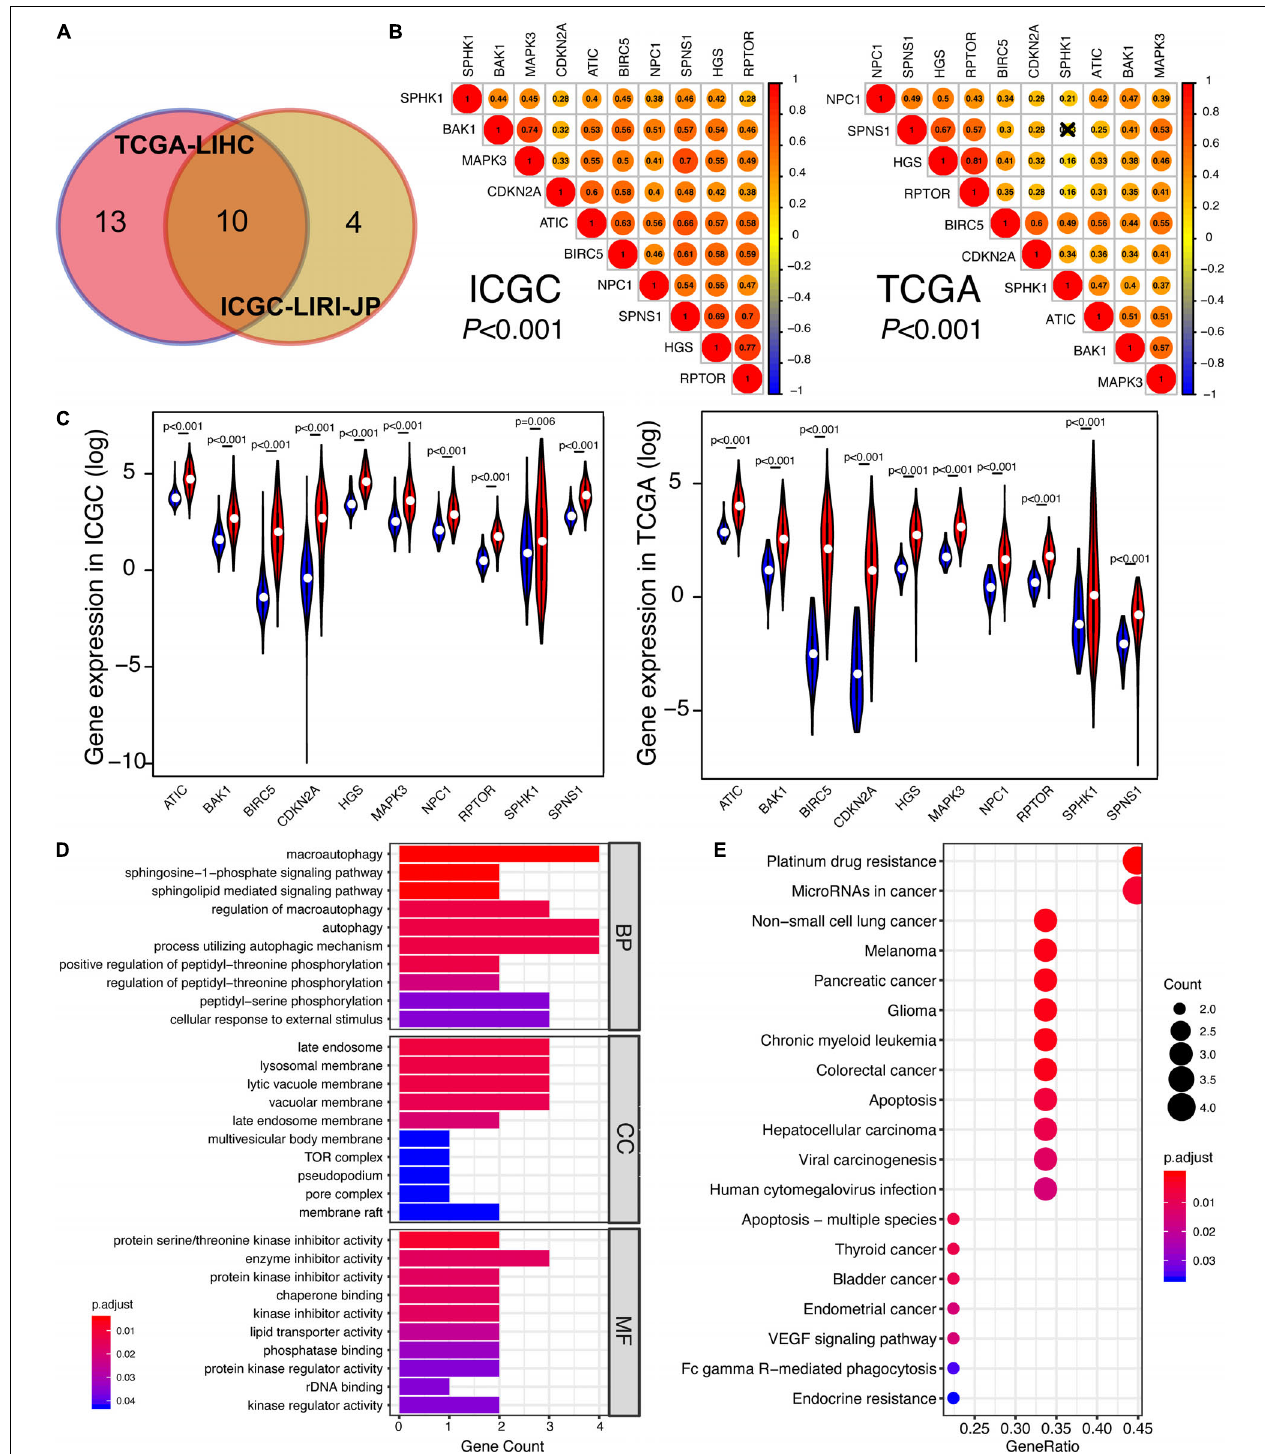
FIGURE 3 | The identification of prognosis-related DEGs in ICGC and TCGA. (A) Venn plot of prognosis-related DEGs between ICGC and TCGA. (B) The correlation among 10 overlapped prognosis-related DEGs in ICGC and TCGA. The closer the correlation between two genes, the bigger the circle size is. (C) Gene expression of 10 hub genes in ICGC and TCGA. The blue color represents the gene expression in normal specimens, while the red color represents the gene expression in tumor specimens. (D) The GO analysis of 10 hub genes, including these following terms: biological process (BP), molecular function (MF), and cellular component (CC). (E) The KEGG analysis of 10 hub genes. “Adjust p < 0.05” was the criterion.